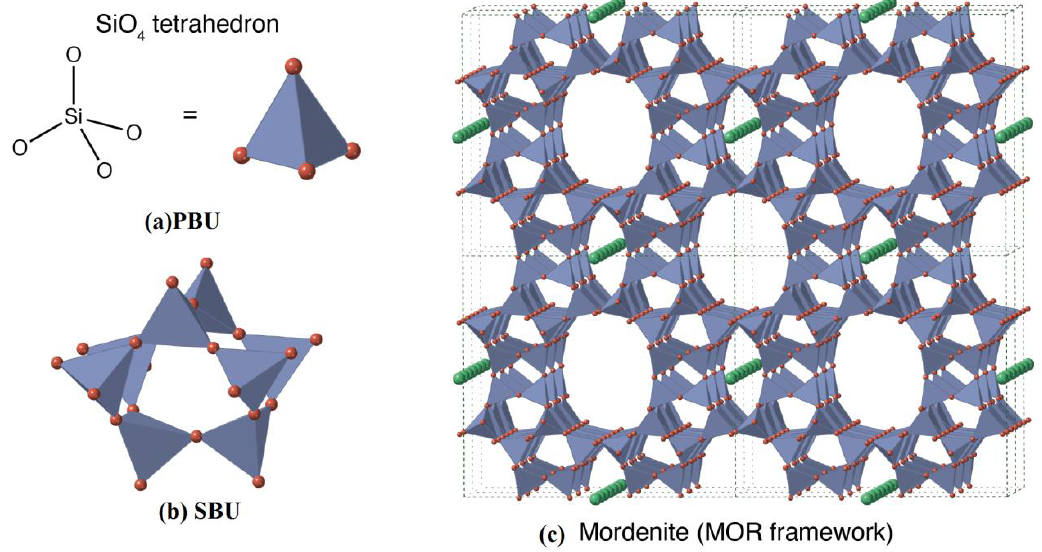
Figure 1. The structure of zeolite ( a ) primary building unit, ( b ) secondary building unit, ( c ) Mor- denite framework accommodating Na+ cations (green atoms) (copy righted François-Xavier Coudert, wikimedia, https://commons.wikimedia.org/wiki/File:Zeolite_structure_as_an_assembly_of_tetrahedra.png) (15 October 2021).